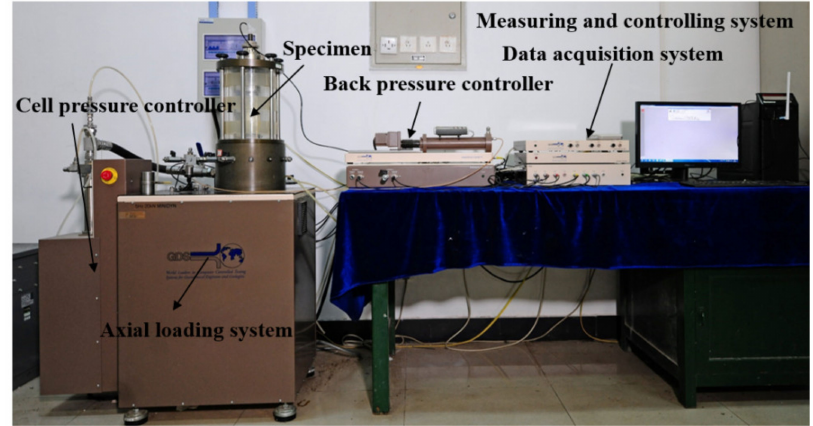
Figure 2. Dynamic triaxial test system.